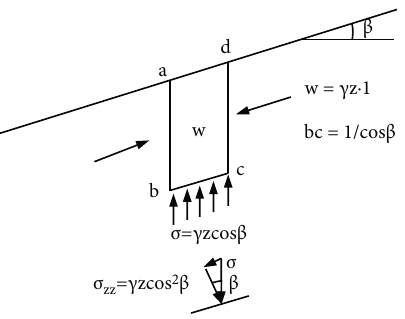
Figure 1: The stress vector on the plane parallel to the inclined surface.